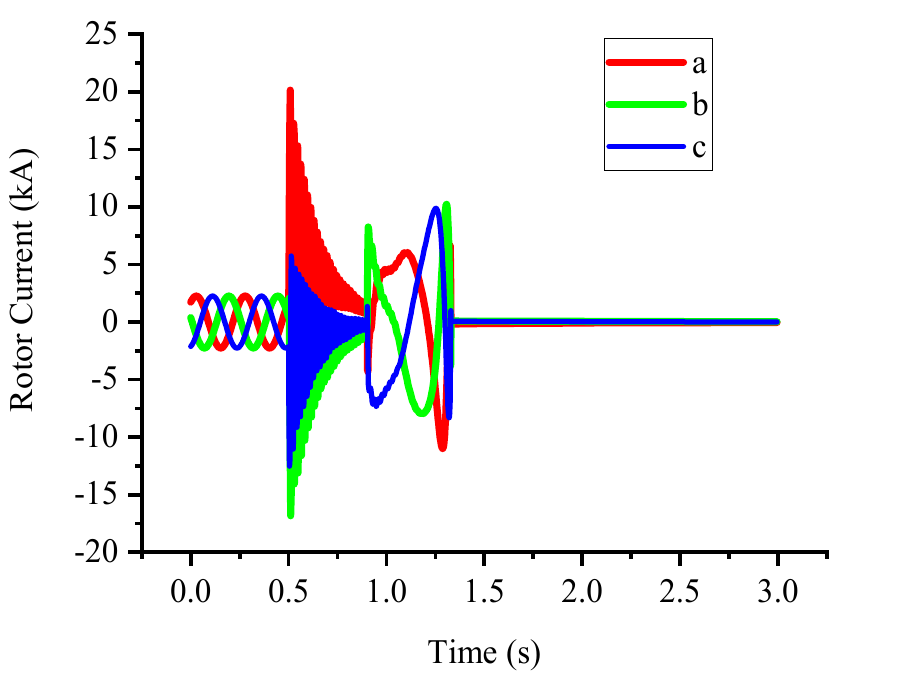
Figure 2. Rotor current curve of the doubly fed induction generator (DFIG) under three-phase short-circuit fault.